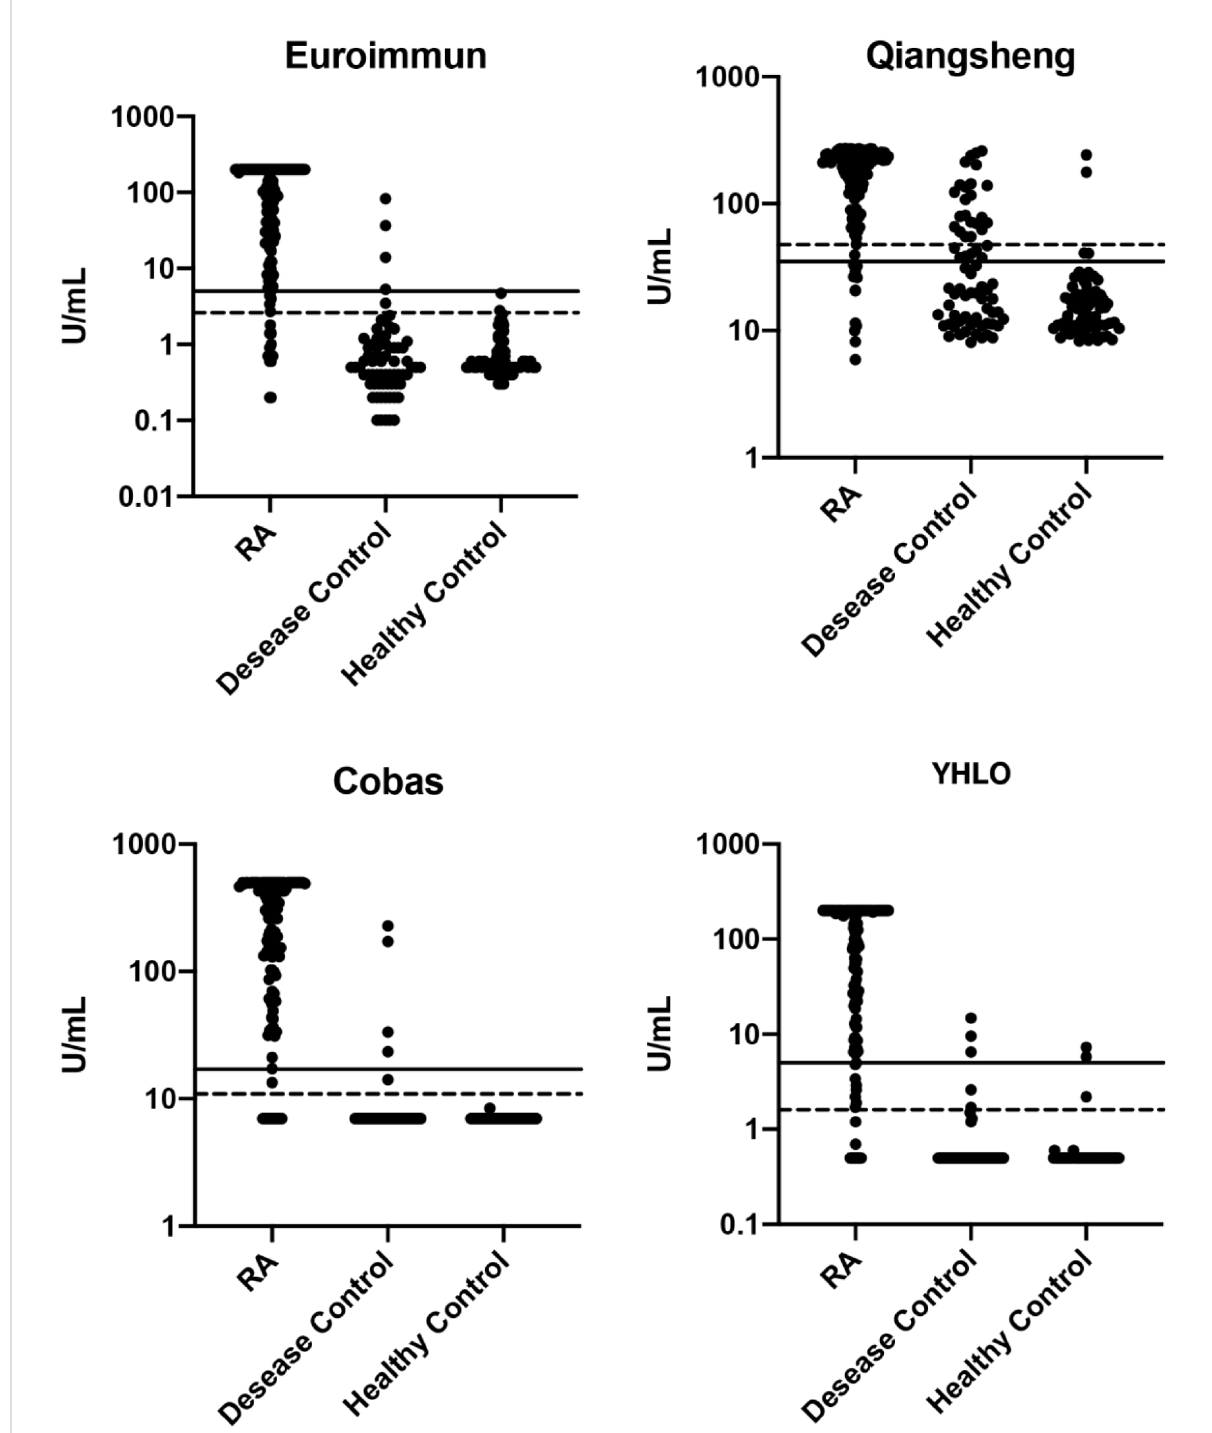
Figure 2 Scatter plots of anti-CCP levels (log-scale) in patients with RA, other autoimmune disease, and healthy controls. Solid lines: manufacturers ’ cut-off values; broken lines: optimal cut-off. RA, rheumatoid